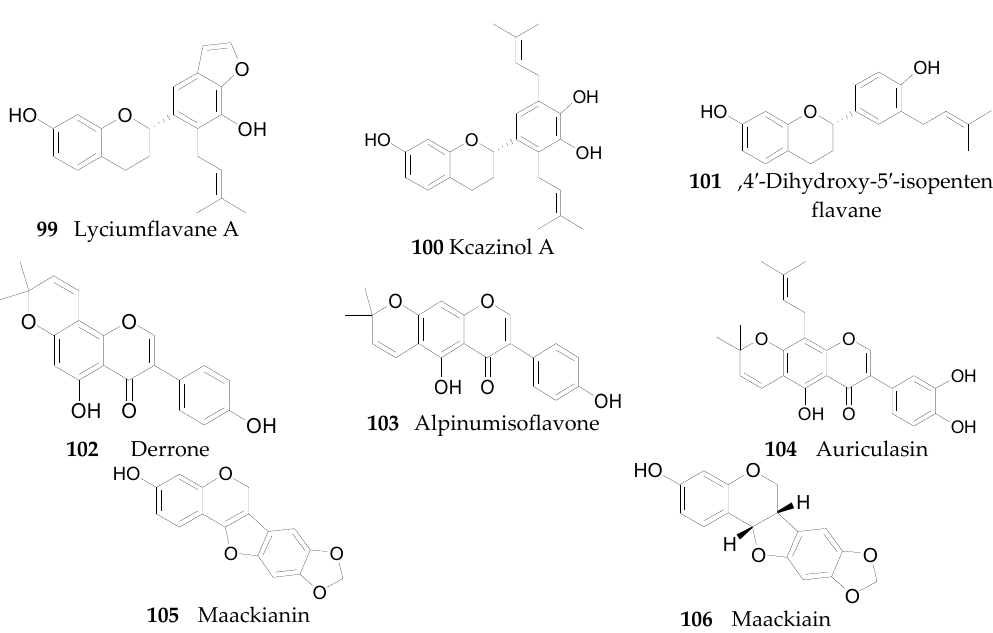
Figure 7. Chemical structures of compounds 99 – 106 .